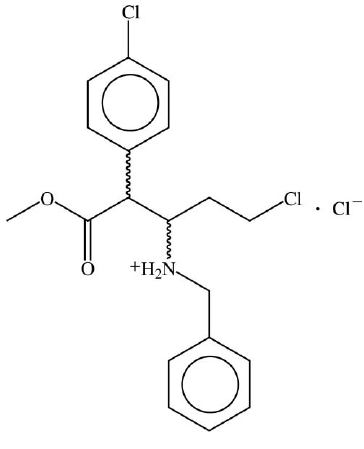
ware used to prepare material for publication: SHELXTL